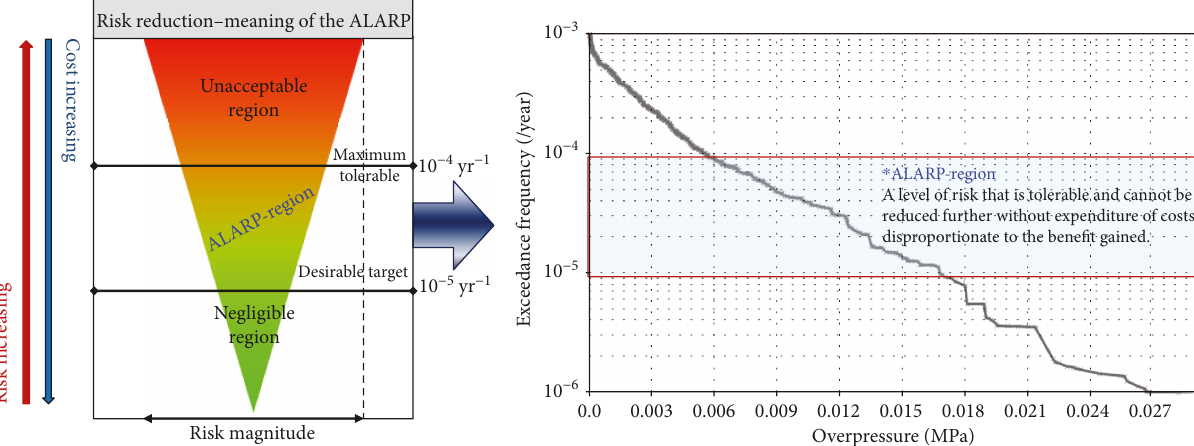
Figure 3: The application of the ALARP principle; the overpressure versus exceedance frequency.